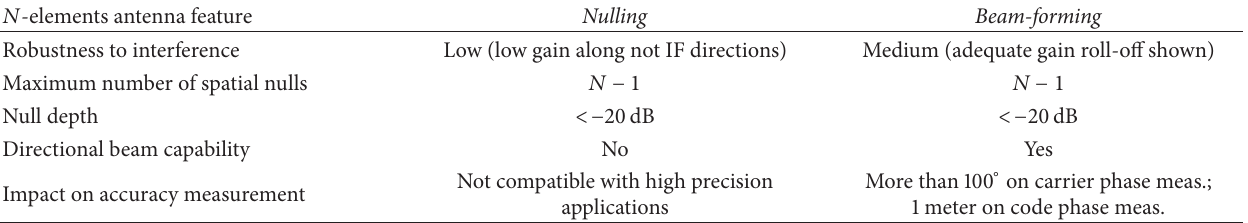
Table 1: Adaptive antenna nulling versus beam-forming